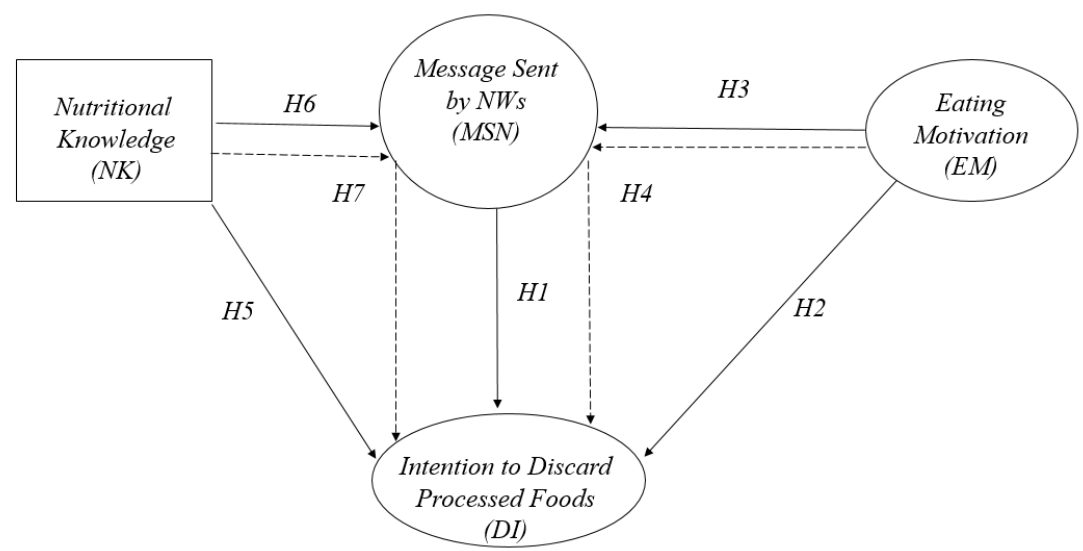
Figure 1. Conceptual Model